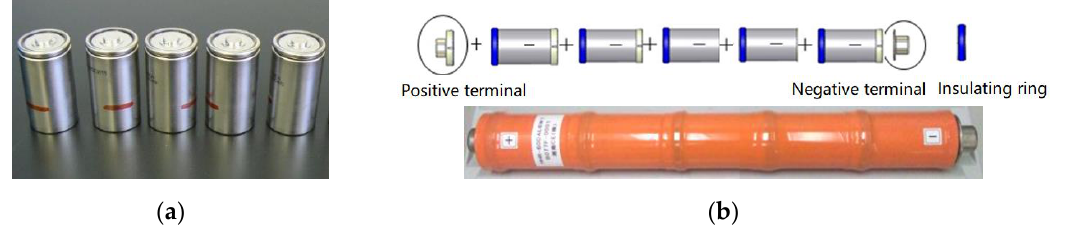
Figure 2. The shape of the battery. ( a ) The battery cells; ( b ) the L5 battery module.